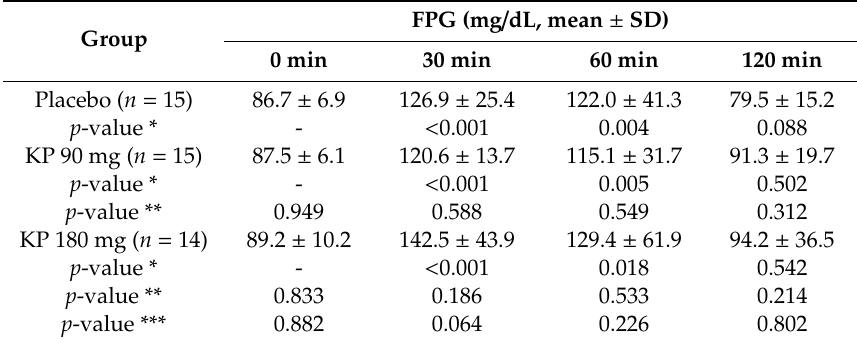
Table 4. Area under the curve (AUC) of blood glucose levels of volunteers after glucose loading at baseline and 28 days of the treatment. AUC of FPG at 0–120 min p -Value* (Baseline vs. Group Day 28)Baseline Day 28 Placebo 2224.1 ± 1122.0 2255.0 ± 1459.6 0.880 KP 90 mg 2014.0 ± 1309.1 1676.0 ± 678.5 0.281 KP 180 mg 2186.0 ± 1119.7 2220.0 ± 1512.3